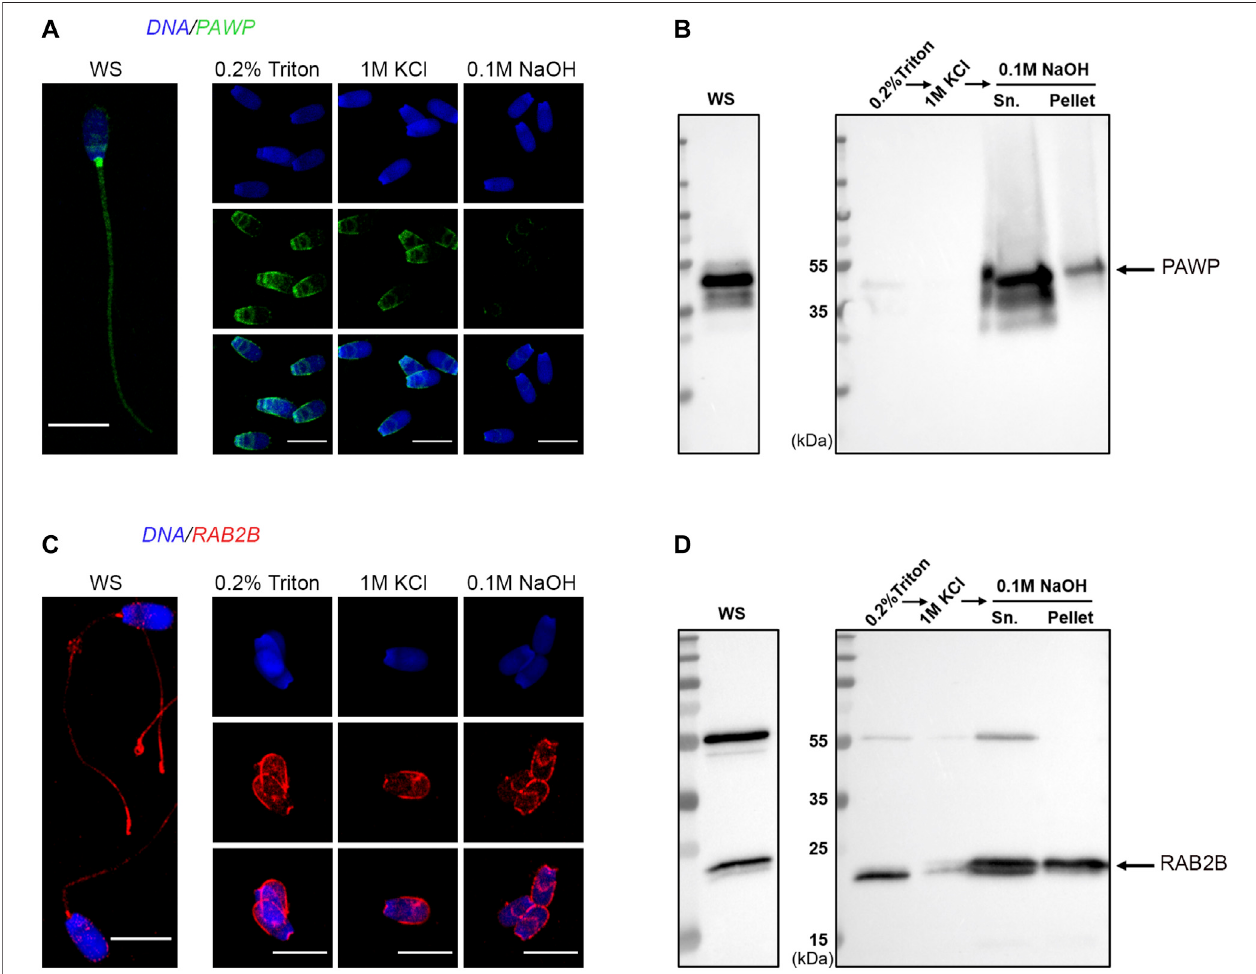
FIGURE 4 | Validation of the presence of PAWP and RAB2B in the boar sperm PT. WS and sperm heads captured from each stage of the PT extraction protocol wereexaminedthroughimmunocytochemistrywithantibodiestoPAWP (A) andRAB2B (C) .Scalebar=10 μ m.ImmunoblottinganalysisofPAWPandRAB2Bafterthe successive extractions and the resulting pellets (pellet) probed with anti-PAWP (B) and anti-RAB2B (D) antibodies.